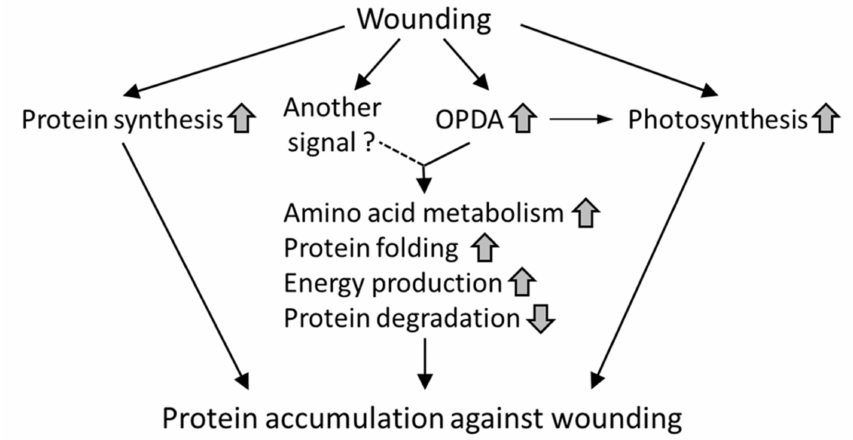
Figure 9. Proposed model for protein accumulation in response to wounding in P. patens. Upward or downward arrows indicate an increase or decrease,